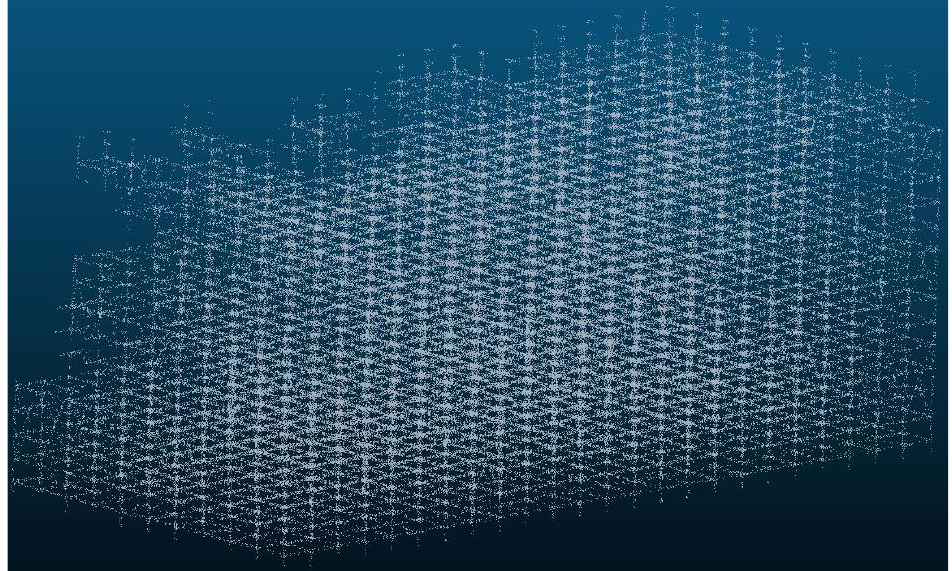
Figure 13. TLS model of the high formwork project.